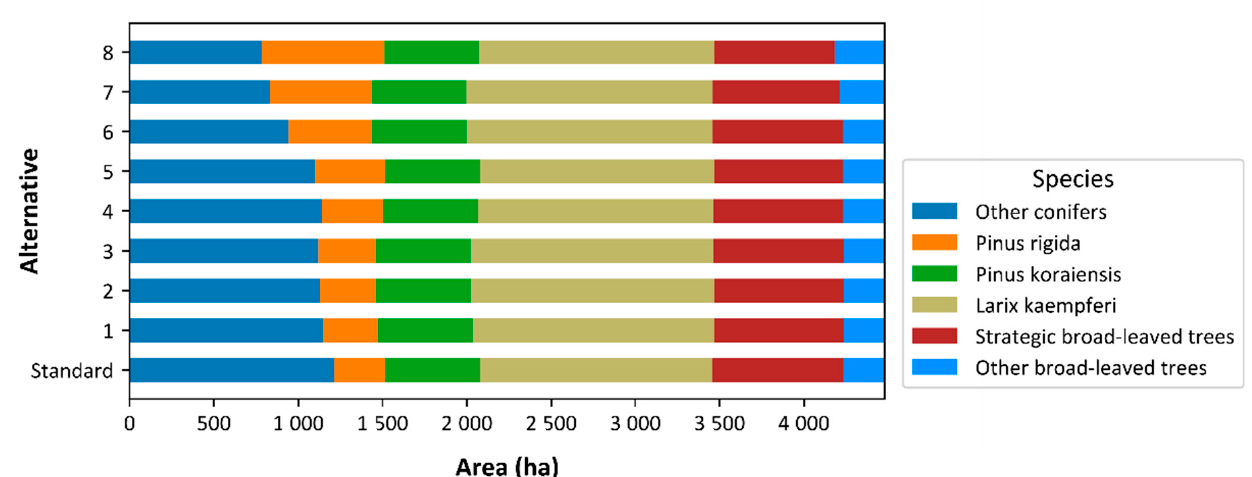
Figure 6. Average area of each species by alternatives for the first to eighth periods. Strategic broad- leaved trees indicate the species specifically planned to expand afforestation in the master plan of the forest, which include Fraxinus rhynchophylla , Juglans mandshurica , Cornus controversa , Betula platyphylla , and Fraxinus mandshurica .